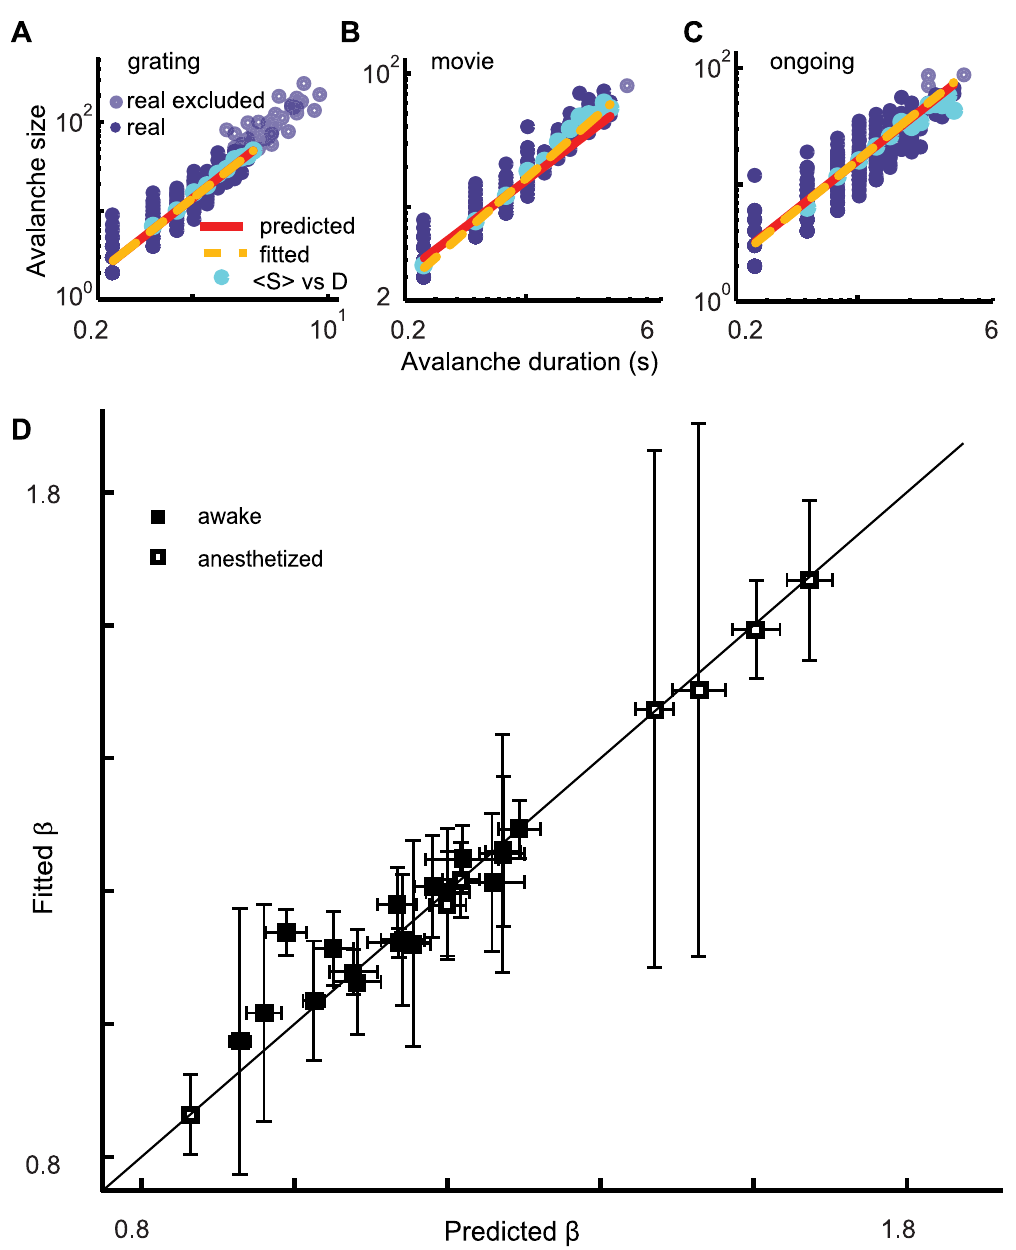
Fig 4. Average avalanche size scaleswith duration as predicted for a network operating near criticality. (A-C) For each avalanche(solid purpledots) the size is plotted (log-log scale) vs the durationfor the three stimulus conditions (mouse #3). For each avalanchedurationthe averageavalanchesize (cyan dots) is plotted. The linear relationship on logarithmicaxes revealsa power law relationship < S > ~ D β betweenaverageavalanchesize and duration as predictedby criticality theory. The fitted exponent β is derived from the linear regressionline (yellow dashes). The predictedline (red) is derived from the predictedexponent β = ( α − 1)/( τ − 1). Solid purpledots were includedin the exponent estimation, open circles were not (see Materialsand methods). (D) The summary plot for all mice shows that the fitted exponent β largely matches the predictedexponent β = ( α − 1)/( τ − 1) for all mice and stimulus conditions. This is despite the fact that different values were found for size exponents τ and duration exponents α for different mice and stimulus conditions.